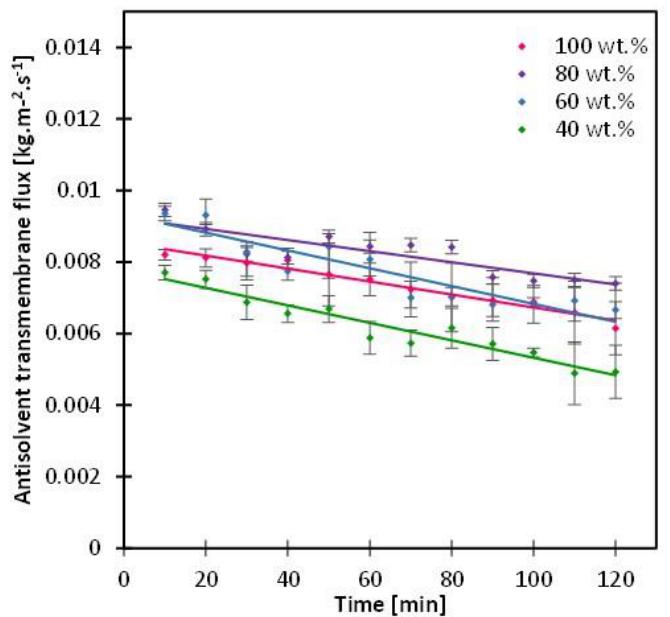
Figure 5. Antisolvent transmembrane flux with variation of antisolvent composition using an ethanol-water mixture of 100-80-60 and 40 wt.% ethanol. Lines are added to guide the eye.